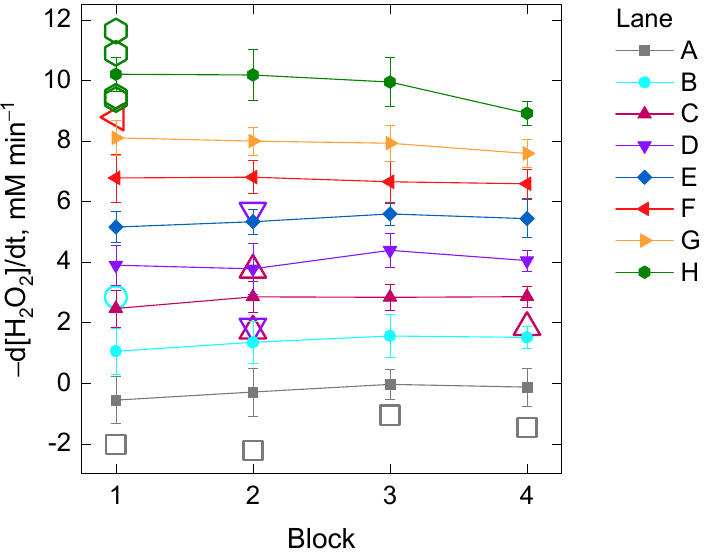
Figure 3. Mean values of the initial rate of the H 2 O 2 decomposition by catalase in four different blocks of samples differing in the kinetic reading time imposed by their position in the 96-well microplate (Experiment II). Each of the mean values per block from Lane A to H (with increasing total protein concentration) belongs to 15 technical replicates of five repetitions as depicted schematically in Figure S2. The open colored symbols are outliers belonging to the lanes with the same color. See the Material and Methods section for further details.